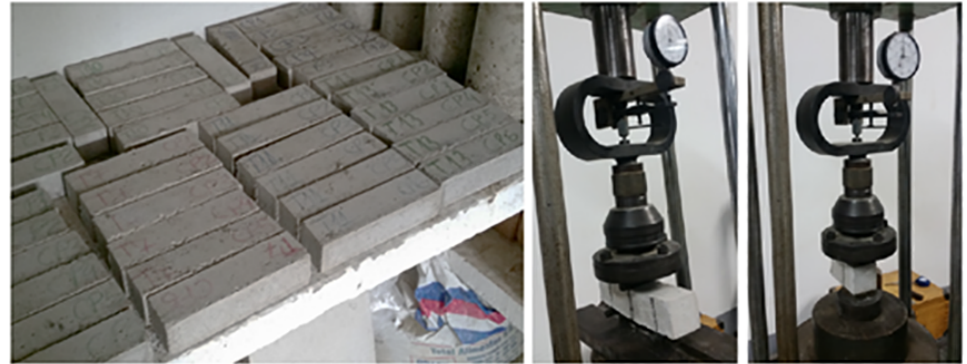
Figure 1. Flexural and compressive strength tests with (4 x 4 x 16) cm prism specimens.